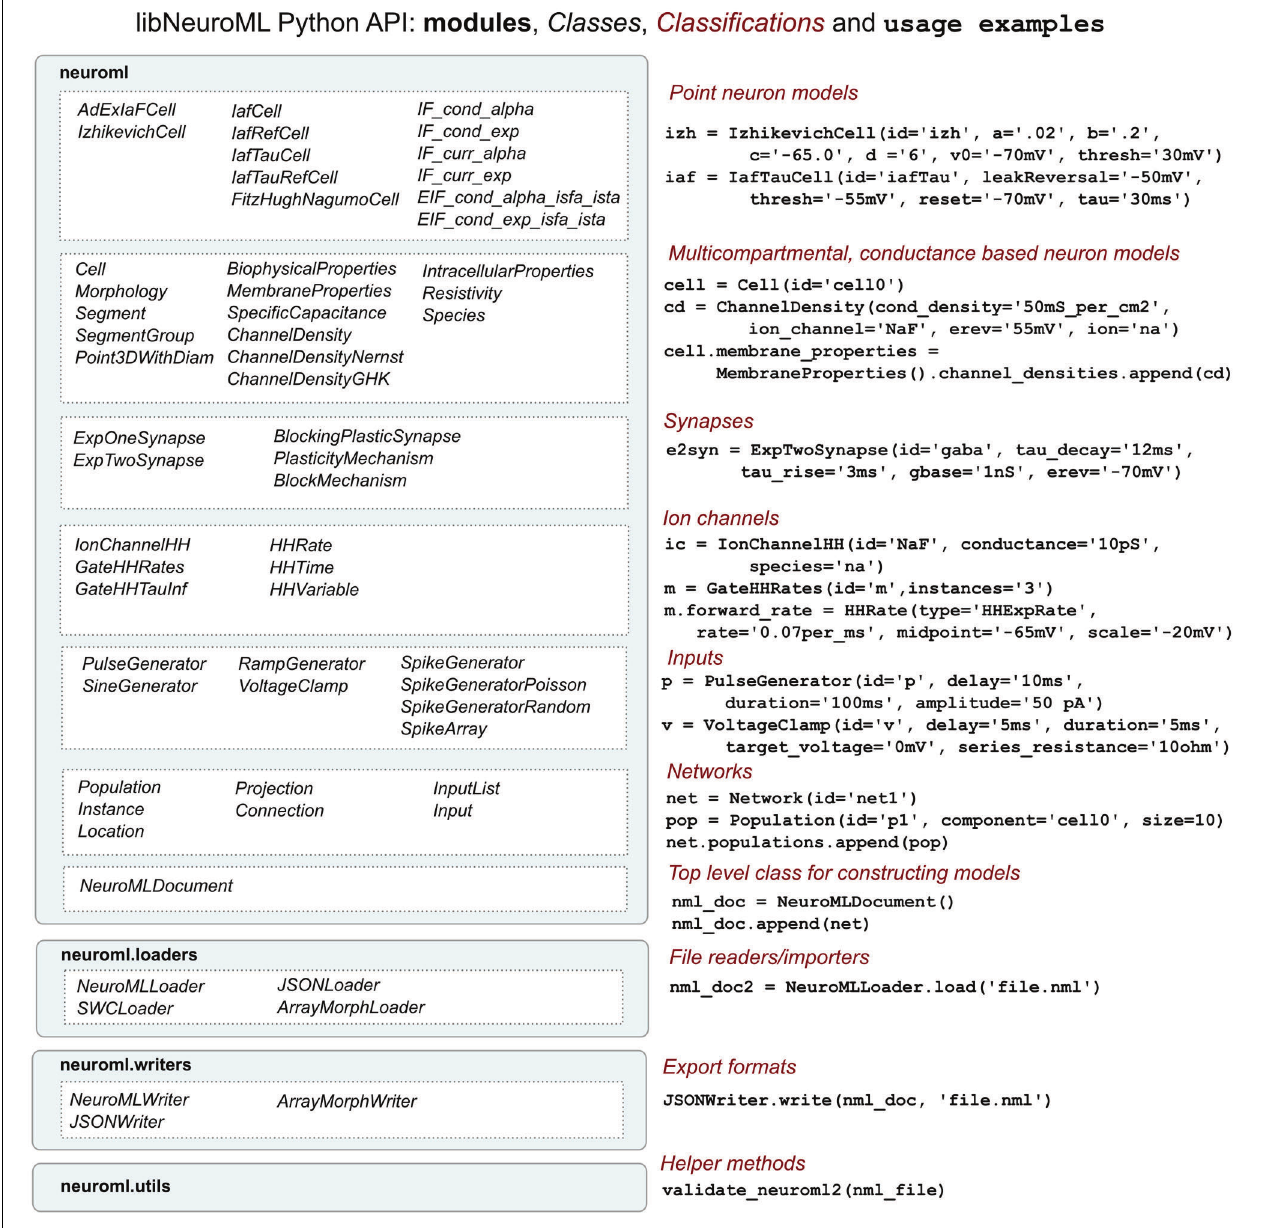
FIGURE 4 | An overview of the structure of the libNeuroML API. The API is divided into four main modules (left), the largest of which (neuroml) consists of Python classes generated from the NeuroML XML Schema Document. There is roughly a one to one correspondence between the NeuroML elements and Python classes. These classes can be split into a